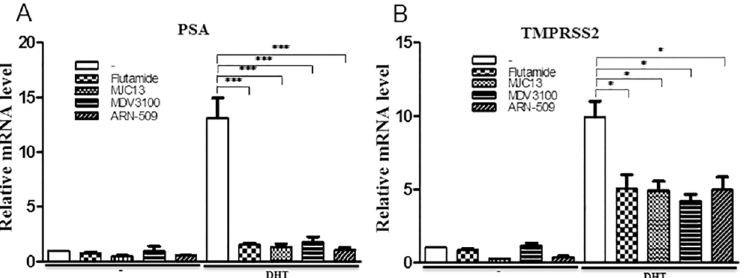
Fig 3. MJC13 and Classic AR antagonists display similar patterns of AR target genes inhibition. qPCR analysis of LNCaP cells extracts treated +/- DHT (1nM), +/- Flutamide (1 μ M), ARN-509, MDV3100 (10 μ M) or +/- MJC13 (30 μ M) for 24 hours. The data are representative of at least three independent experiments. All values represent the mean ± SD of triplicate samples. (A) PSA gene. (B) TMPRSS2